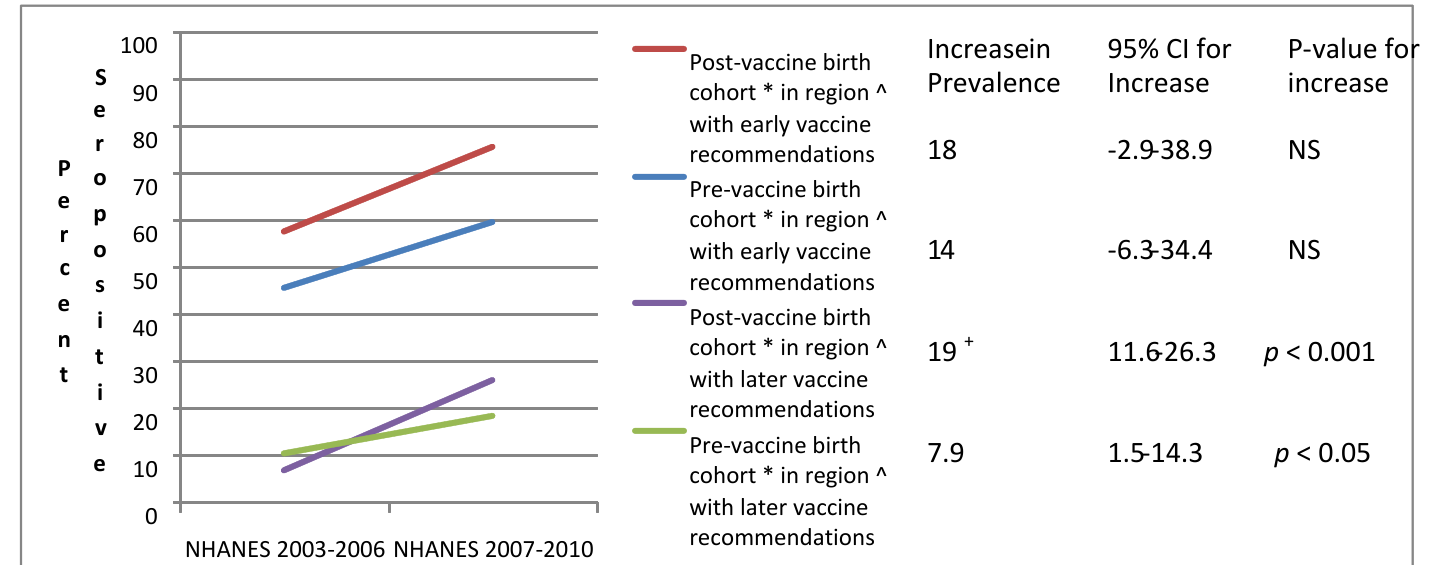
Figure 1. HAV seropositivity over time among U.S. born children and adolescents 6–19 years old stratified by birth cohort and region of the U.S.: NHANES 2003–2006 and